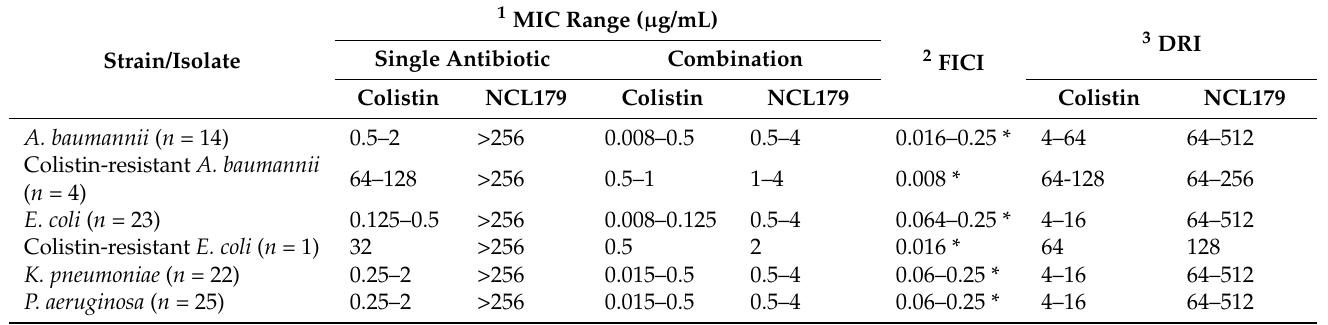
Table 2. Synergistic activity of NCL179 in combination with colistin against reference strains and clinical isolates of Gram-negative